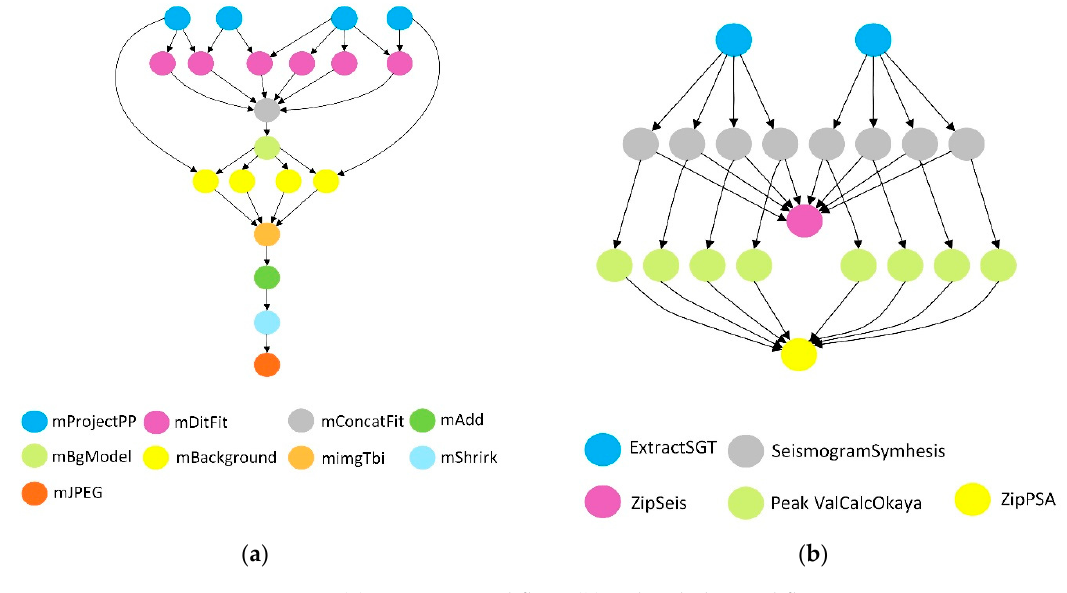
Figure 5. (a) Montage workflow; (b) Cybershake workflow. Figure 5. ( a ) Montage workflow; ( b ) Cybershake workflow.